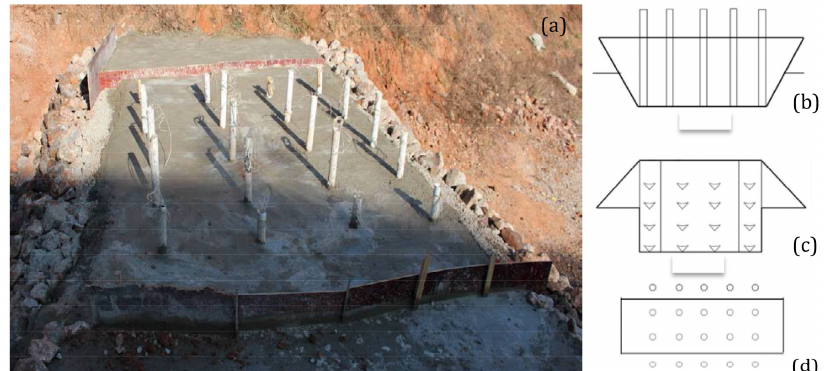
Figure 3. Photo after the installation of the PRW ( a ). The front ( b ); side ( c ); and top ( d ) view of the PRW. The top was covered with 0.3 m of concrete to prevent vertical leaching. The left is upstream. Water flows from left to right. The board was later removed. The PWR was in the middle and the front and back portions outside the board were filled with concrete only, thus, no monitoring wells were installed in these portions. Each PVC pipe had 4–5 monitoring wells inside at different